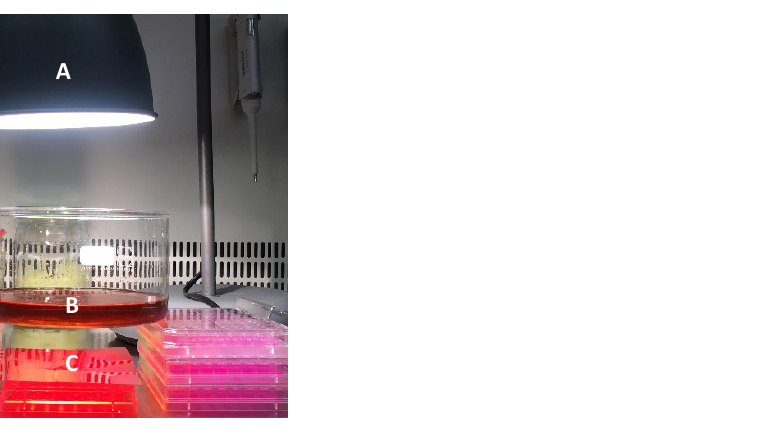
Figure 2. In vitro assays using cell lines under irradiation. ( A ) Halogen/tungsten lamp; ( B ) aqueous solution of iron(III) nitrate, ( C ) 96-well plates and cut-off filter to remove light of wavelength below ~500 nm.